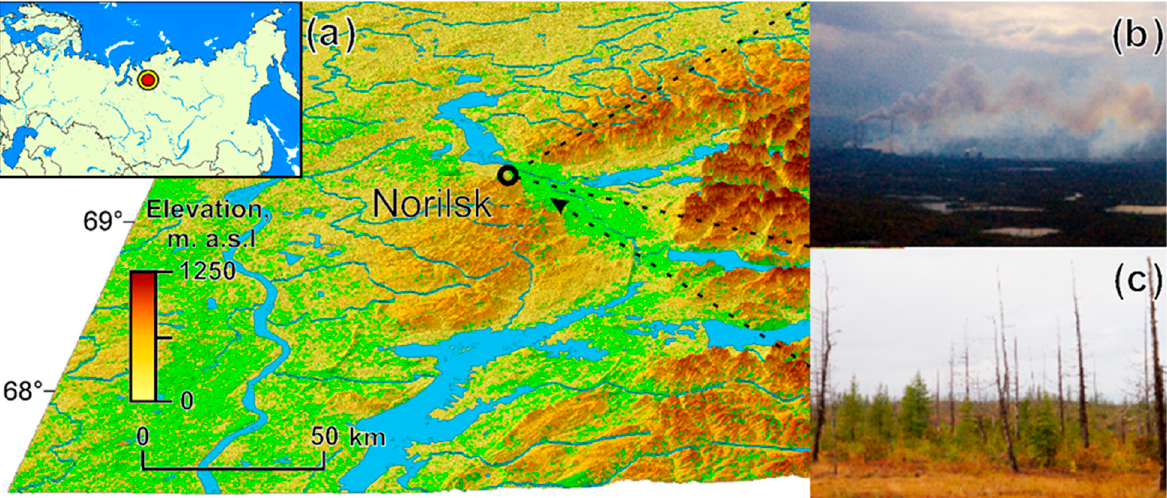
Figure 1. ( a ) The study area. The background: green shows NDVI index mean values (2001–2022); yellow-brown colors show elevations. ( b ) Airborne view of the emissions plum. ( c ) An example of larch forest within SO 2 emission influence zone.